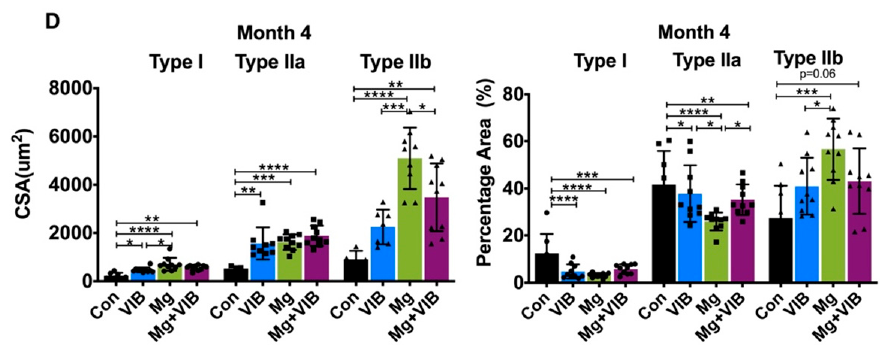
Figure 2. Immunohistochemical staining of myofibers (myosin heavy chain expression) in different groups at month 2, 3 and 4 post treatment. ( A ) Type I muscle fibers (blue), type IIa muscle fibers (green) and type IIb muscle fibers (red) of gastrocnemius at month 2, 3 and 4. ( B – D ) Type I, IIa and IIb CSA and percentage area in different treatment groups at month 2, 3 and 4. Scale Bar: 100 μ m. * p < 0.05, ** p < 0.01, *** p < 0.001 and **** p < 0.0001, n = 5–10.